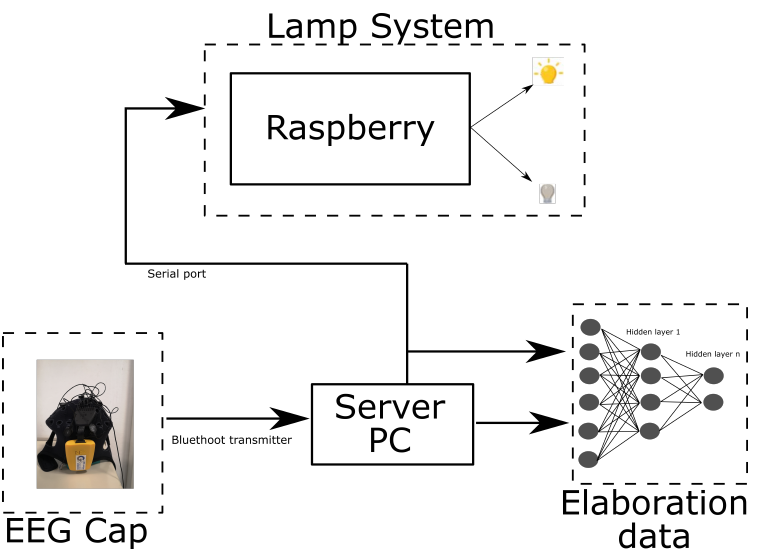
Figure 1. System architecture.